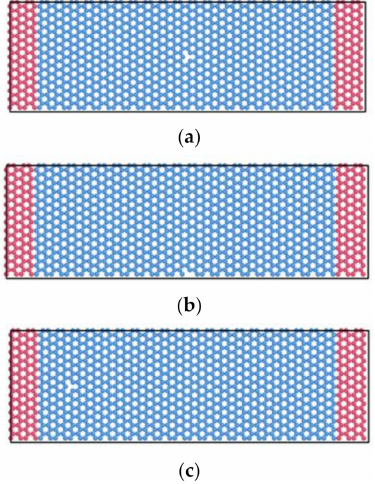
Figure 3. Schematic diagram of three type graphene nanoribbons containing single atom vacancy. ( a ) SV-1 model of the single atom vacancy at the center position. ( b ) SV-2 model of the single atom vacancy at the edge position. ( c ) SV-3 model of the single atom vacancy at other